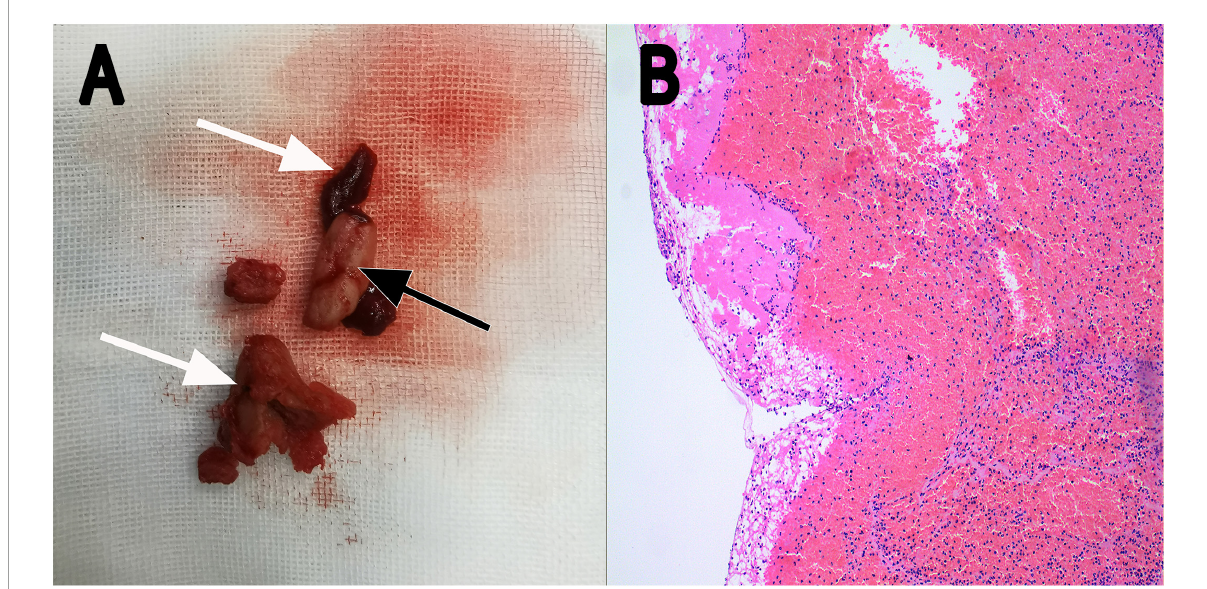
FIGURE3 (A) Thrombotic substance and vegetations removed by surgery in gross appearance (white arrow: thrombotic substance; black arrow: vegetation). (B) Fiber-like substance and many red blood cells were seen under the microscope (H&E staining; magnification, × 10). H&E, hematoxylin and